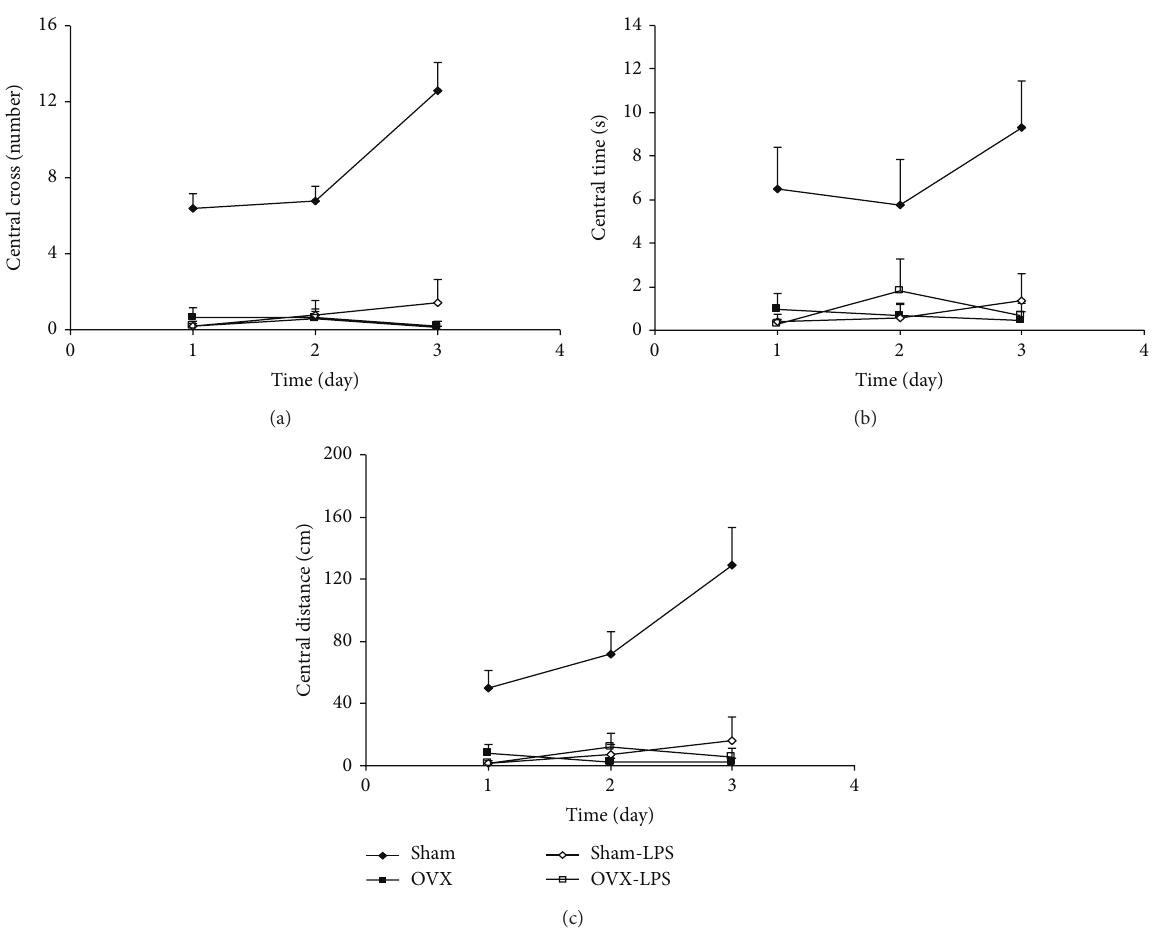
Figure 2: Comparison of central crossing number (a), the time spent in central zone (b), and the traveled distance in central zone (c) in the open field test between four groups. Data are expressed as mean ± SEM ( 𝑛 = 10 in each group). The time spent and the traveled distance in the central zone in both OVX and Sham-LPS groups were lower than that of the Sham group ( 𝑃 < 0.001 ). There were no significant differences between OVX-LPS and OVX